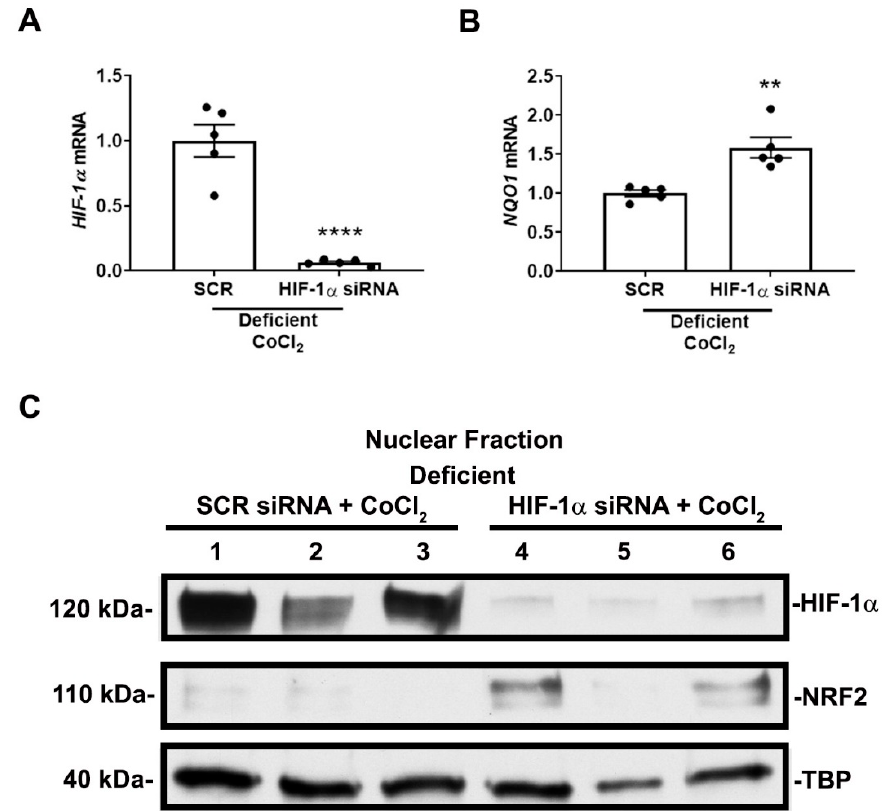
Figure 7. HIF-1 α mediates NRF2 nuclear localization and activity in nutrient-deficient conditions. ( A , B ) HIF-1 α and NQO1 mRNA expression after siRNA transfection and exposure to 16 h of defi- cient conditions in the presence of 200 µM CoCl 2 . Transfection results in greater that 90% knock- down efficiency in HIF-1 α mRNA expression. siRNA-mediated HIF-1 α knockdown increases NQO1